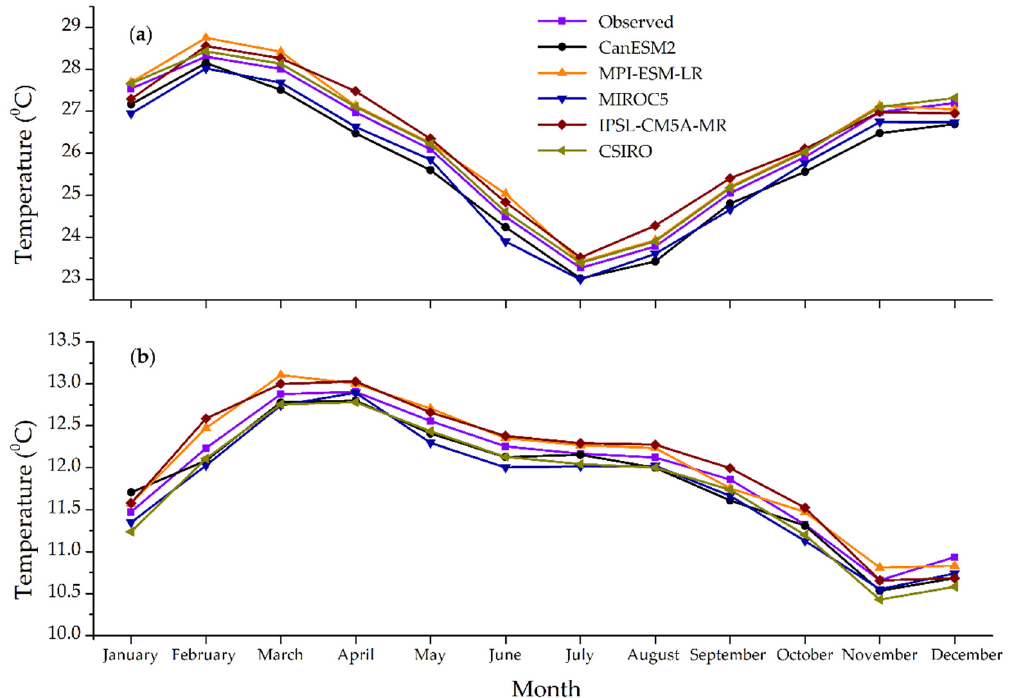
Figure 6. Observed monthly temperature and GCM simulated temperature in the baseline period (1986–2005): ( a ) maximum temperature; and ( b ) minimum temperature.